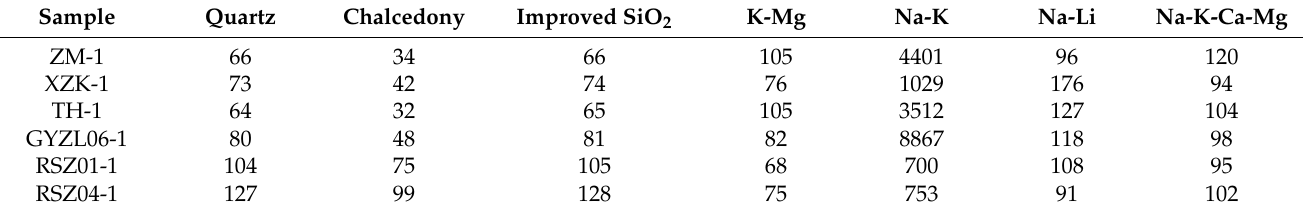
Table 5. Estimated reservoir temperature of thermal ground waters by applying different